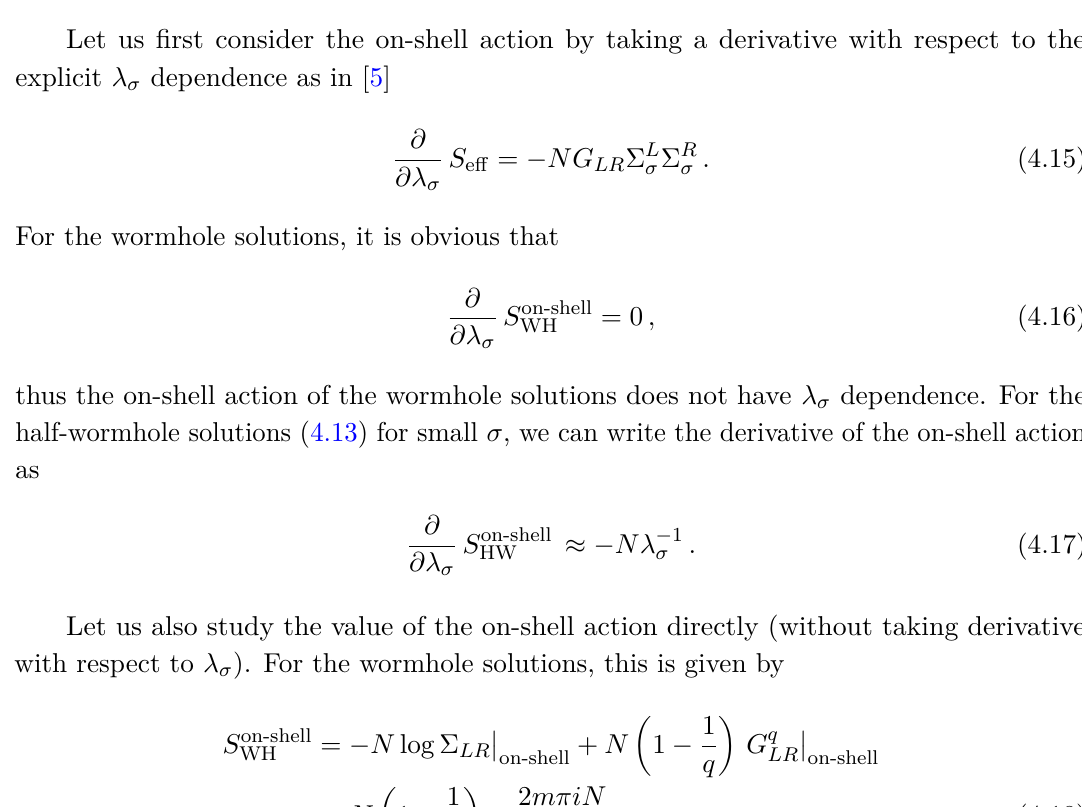
Figure 2 . The half-wormhole saddles in the totally fixed-coupling limit for q = 12